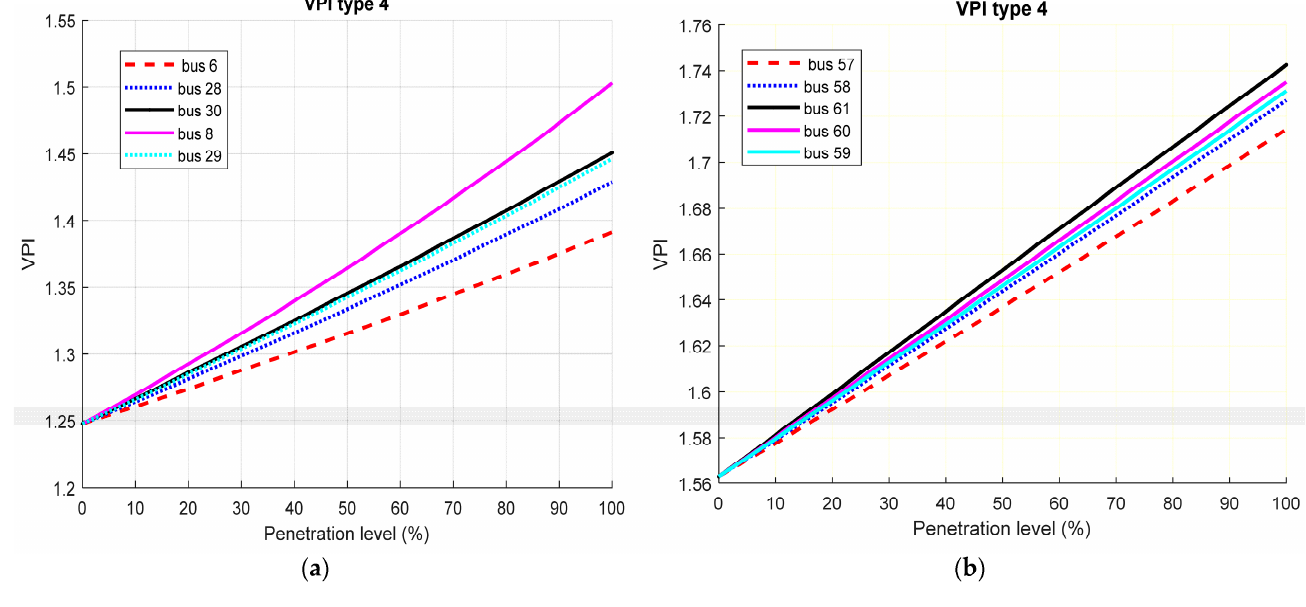
Figure 24. VPI when Type 4 DG was interconnected to the selected nodes of IEEE ( a ) 33-bus ( b ) 69-bus RDNs.